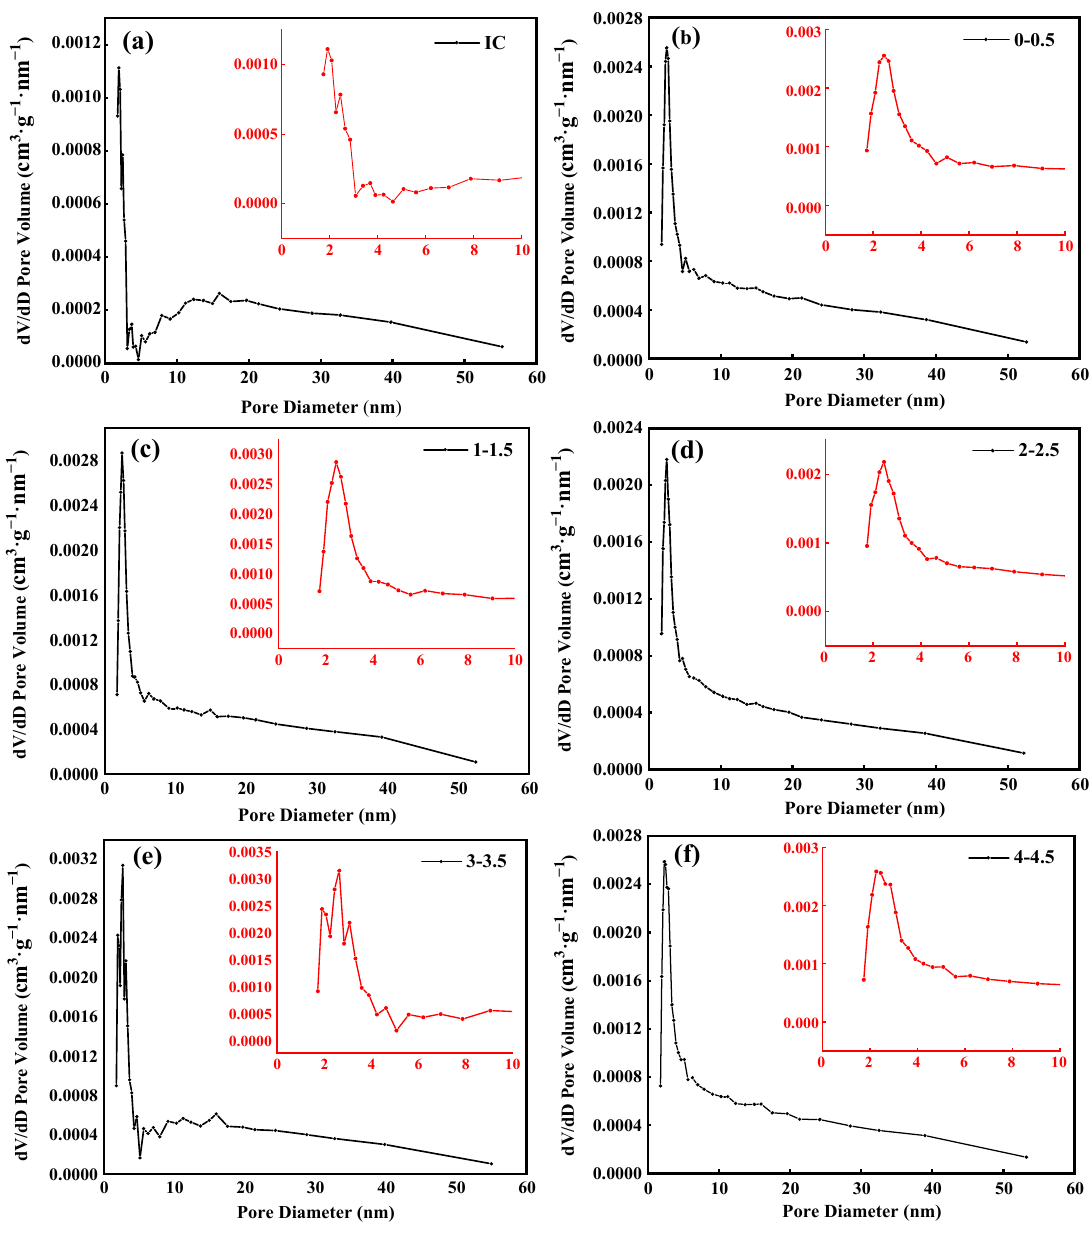
Figure 8. Pore size distribution of IC and TC. ( a ) IC; ( b ) 0–0.5; ( c ) 1–1.5; ( d ) 2–2.5; ( e ) 3–3.5; ( f ) 4–